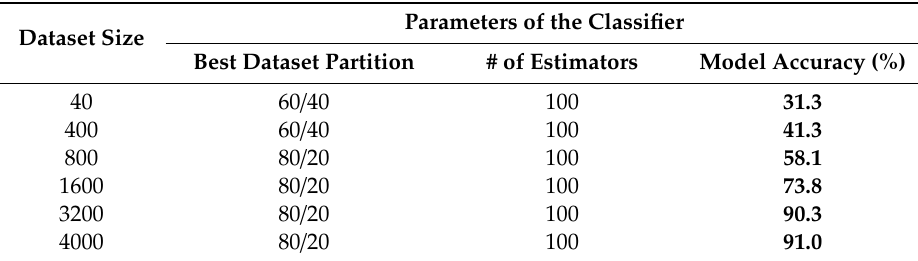
Table 4. Random forest classifier (RFC): best results.